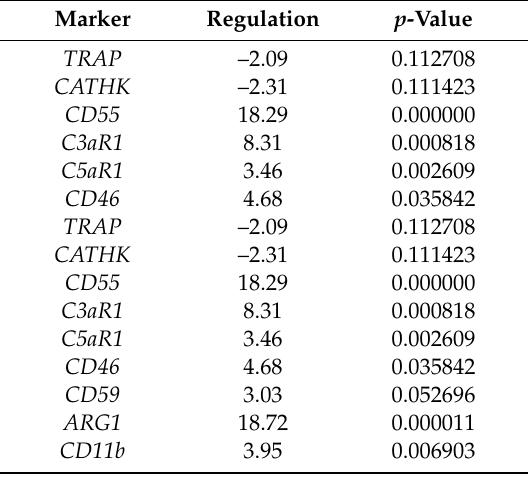
Figure 5. Volcano plot for gene expression analysis of PEEK compared to Ti (28 days). Only 2 subjects to be interpreted with caution. Downregulation (vertical green line) and upregulation (vertical red line) set at × 2 regulation. Statistical significance (set at p < 0.05) when marker above horizontal blue line. Table 6. Gene expression analysis of PEEK compared to Ti (28